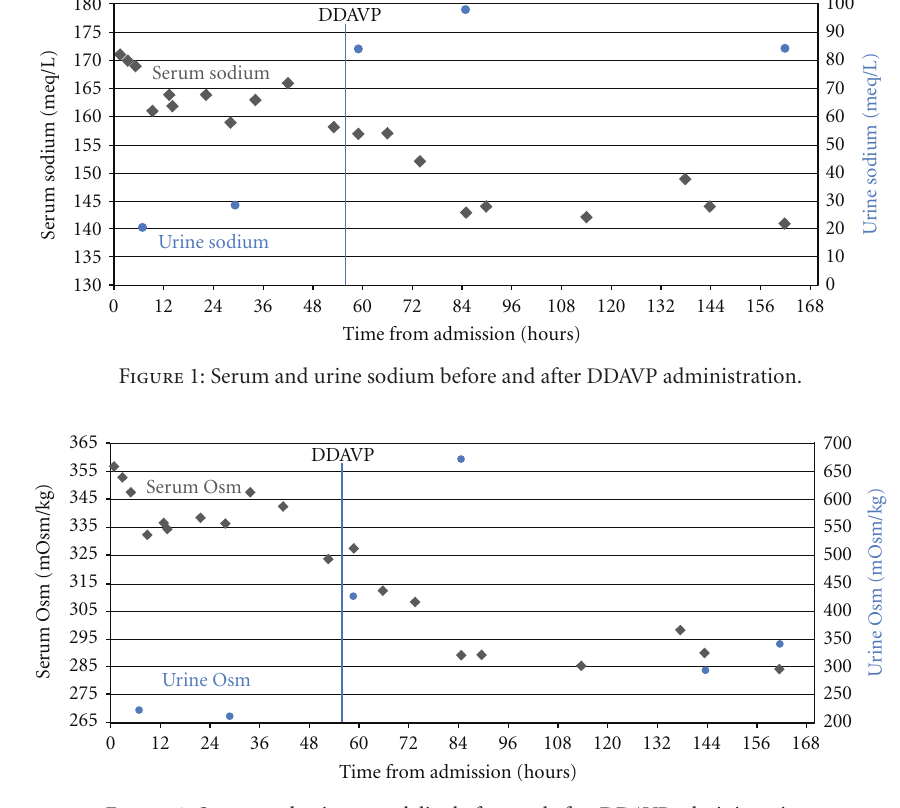
Figure 2: Serum and urine osmolality before and after DDAVP